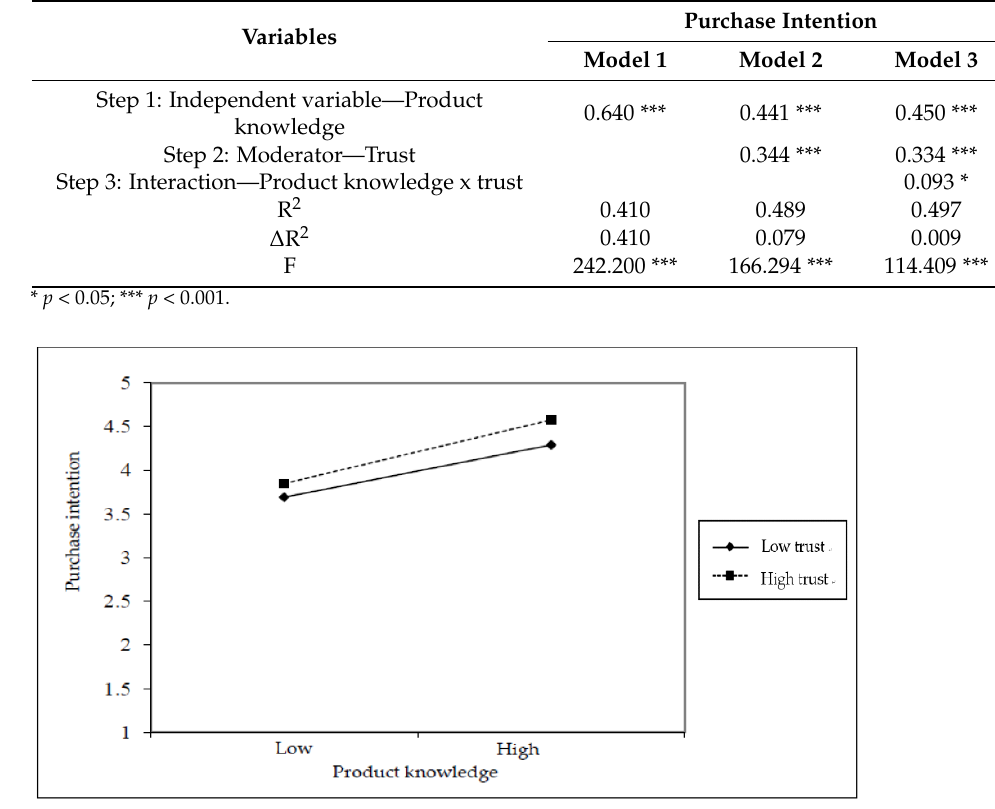
Figure 3. The interactive effect of product knowledge , purchase intention and trust .